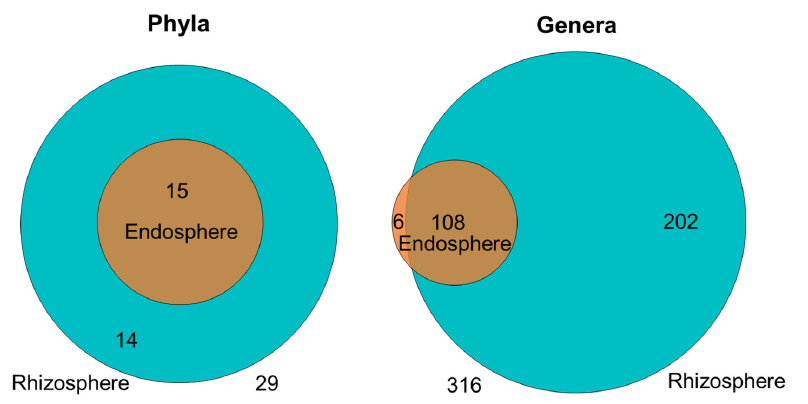
Figure 5. Distribution of shared and unique taxa by compartment. The diameters of the circles illustrate the number phyla ( left ) and genera ( right ) in each compartment (green-cyan, rhizosphere; orange, endosphere), numbers of unique taxa shown inside circles, numbers of shared taxa shown in overlapping areas, total numbers shown below the Venn Diagram.